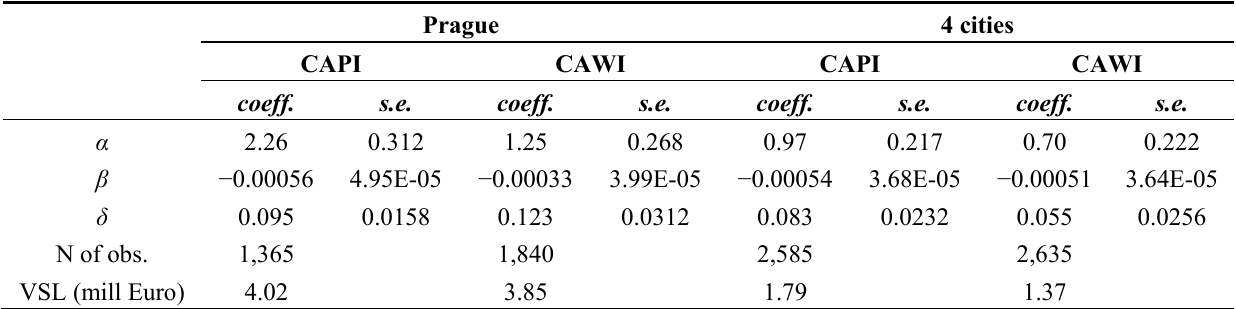
Table 6. VSL estimations for different cities and the mode of survey